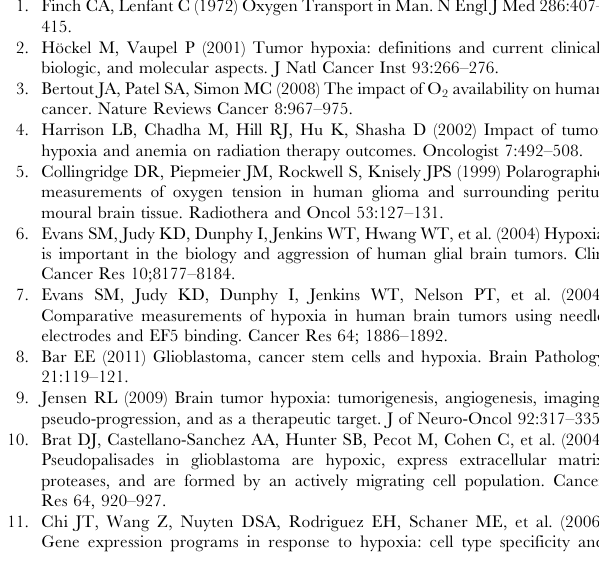
Table S1 Glioma-associated tumor antigens and key immunological information. Table S2 qRT - PCR primers used for this study. (DOCX) Figure S1 Two-color fluorescent microscopy shows co- localization of Whsc2 and YKL-40 with HIF-1 a in U251 CD133 + ‘‘stem-like’’ cell induced tumors. Human U251 neurosphere ‘‘stem cells’’ were implanted into the brain of a nude mouse. When the glioma was showing an effect on the mouse, the mouse was euthanized and the brain was removed. Serial sections were cut and then stained with either anti-HIF-1 a (red), Whsc2 (green) or YKL-40 (green). The nuclei are stained with DAPI (blue). Panel B shows a magnified region that was highlighted from Panel A.